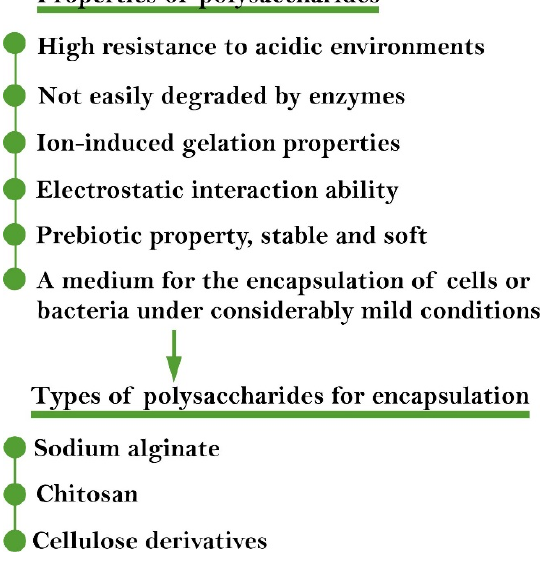
Figure 3. Advantages of polysaccharides for encapsulation of PGPB.